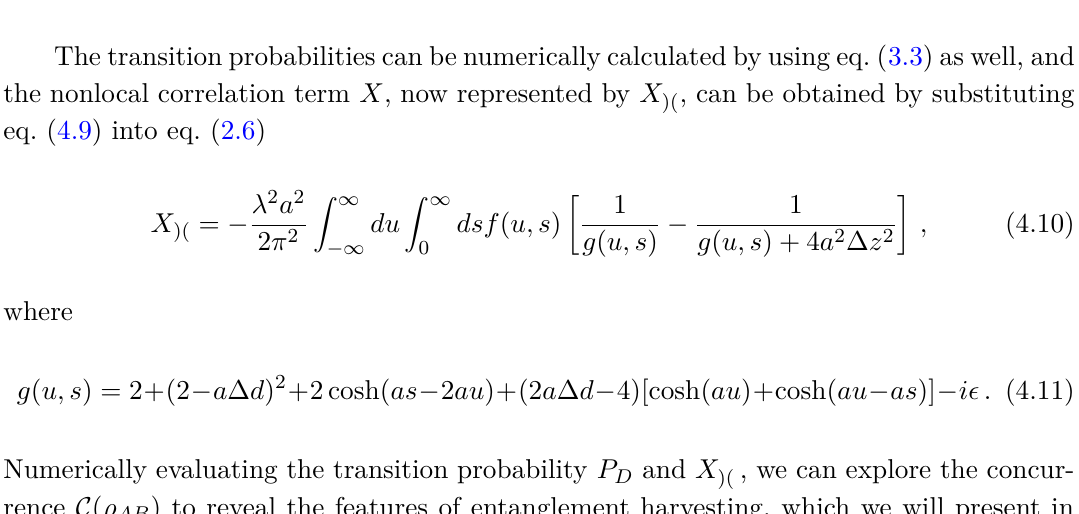
Figure 6. (a) Two detectors in anti-parallel acceleration near the reflecting boundary with a nearest longitudinal shift ∆ d along the direction of acceleration, (b) the corresponding worldlines of two detectors. Black arrows indicate the direction of